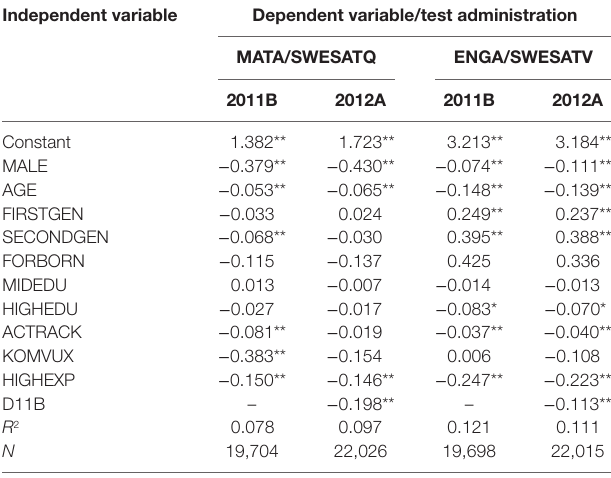
taBlE 3 | Least squares estimates of score differences between grades and Swedish admissions test (SweSAT) quantitative and verbal parts.